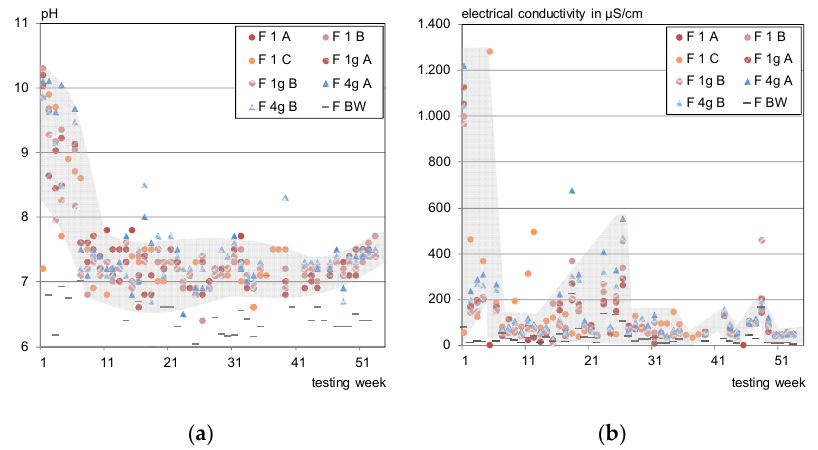
Figure 19. ( a ) Eluate pH in the outdoor testing; ( b ) electrical conductivity in the outdoor testing. Figure 20 exemplarily shows the individual concentrations of sodium, calcium, arsenic and vanadium for the outdoor test specimen F 1g A and F 1g B. Sodium, arsenic and vanadium developed a nearly identical concentration pattern. Sodium shows a slightly higher response to dry or semi-dry phases, which is attributed to its lower bonding to the concrete matrix.